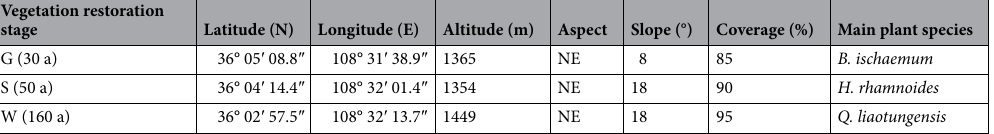
Table 1. Geographical and vegetation characteristics at different vegetation restoration stages in the Ziwuling forest region of the Loess Plateau. G represents grassland, S represents shrubland, and W represents woodland. The numbers in parentheses are the years since cropland